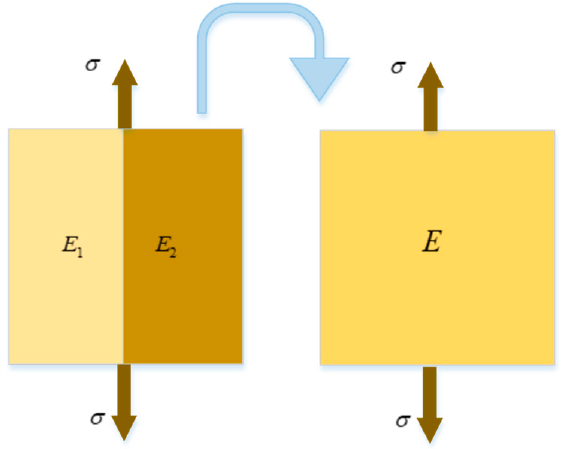
Figure 2. Voigt parallel model.